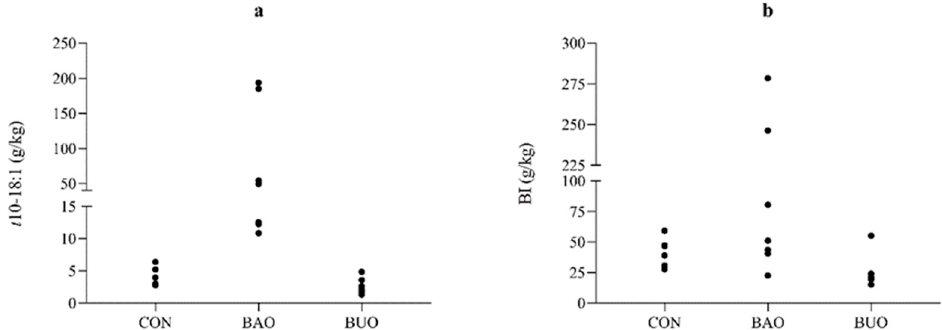
Figure 1. Proportion of t-10 18:1 ( a ) and total biohydrogenation intermediates (BI) ( b ) in abomasum content of sheep fed control diet (CON) or supplemented diets with babassu (BAO) or buriti (BUO) oil. The BAO supplementation increased the proportion of PUFA ( p = 0.041) and decreased the proportion of 18:0 ( p = 0.001) in the abomasal content of lambs compared with the CON and BUO diets (Table 5). The 16:0 ( p = 0.041) and 18:2 n-6 ( p = 0.028) were less and SFA ( p = 0.001) content was greater in abomasum of lambs fed BUO compared with BAO. The